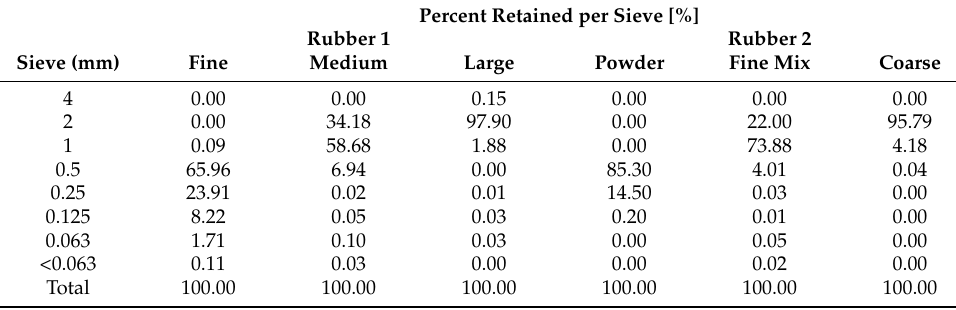
Table A2. Crumb rubber sieve